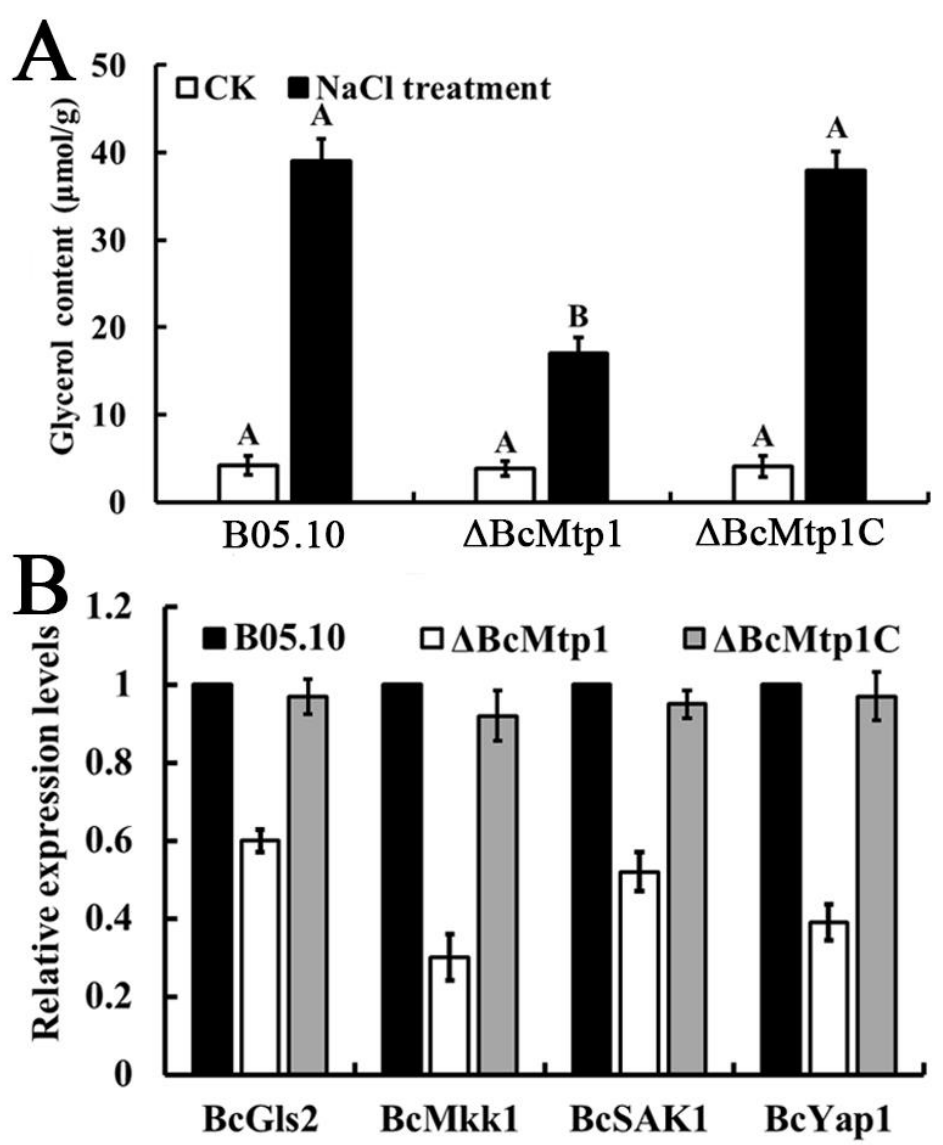
Figure 4. Involvement of BcMtp1 in glycerol accumulation and expression levels of various stress response genes ( A ) Glycerol content in mycelia of B05.10, ΔBcMtp1 , and ΔBcMtp1C. The glycerol was extracted from the mycelia of each strain untreated or treated with 0.7 M NaCl (NaCl treatment) for 2h after growth in YEPD, in the dark. The cultures without treatment were used as controls (CK). Bars denote standard errors from three repeated experiments. Values on the bars followed by the same letter are not significantly different at p = 0.05. ( B ) Expression levels of cell-wall integrity relation genes ( BcMkk1 and BcGls2 ) and oxidative stress relation gene ( BcYap1 and BcSak1 ) in each strain. RNA samples were extracted from the mycelia of each strain after being grown in YEPD for 2 d (25 °C, 175 rpm), in the dark. Bars denote standard deviation from three repeated experiments. Values on the bars followed by the same letter are not significantly different at p = 0.05.